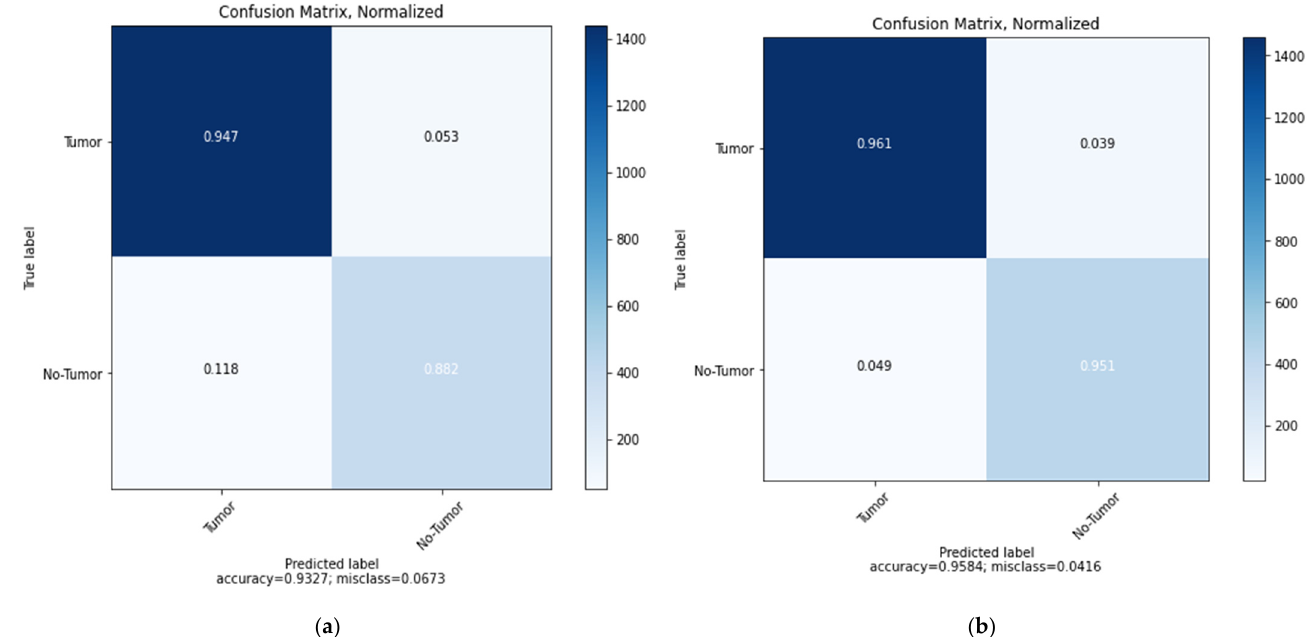
Figure 10. Confusion matrix for the proposed MobileNetV2 model: ( a ) using Vanilla GAN image generated; ( b ) using DCGAN image generated.